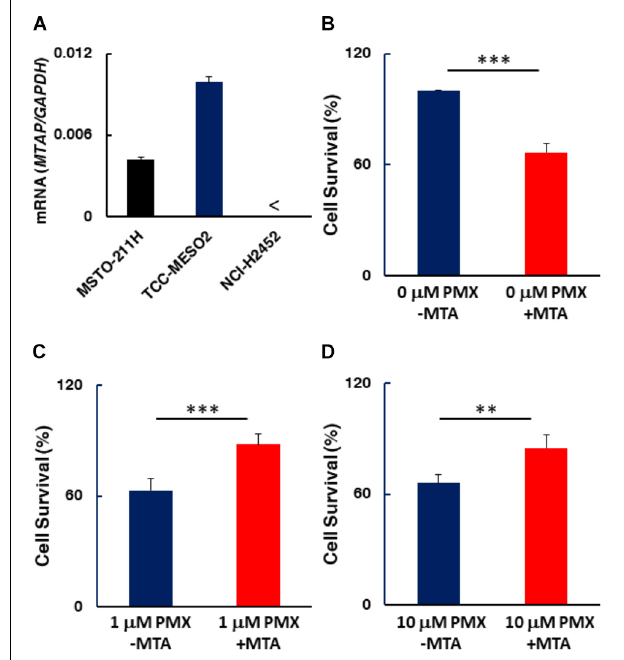
FIGURE 7 | MTAP expression in MPM cells and effect of MTA on MPM cell survival. (A) MTAP mRNA expression was evaluated by real-time RT-PCR using the (cid:49)(cid:49) CT method normalized to the housekeeping gene GAPDH. < indicates not detected (N.D.). Error bars indicate s.d. (n = 6). (B–D) Addition of 5 (cid:48) -deoxy-5 (cid:48) -(methylthio)-adenosine (MTA) represses drug-resistant cells. NCI-H2452 cell survival (%) was measured in the presence of 0.1 mM MTA co-treated without (B) or with either 1 µ M (C) or 10 µ M pemetrexed (D) . The data are shown as the mean ± s.d. ( n = 6). Error bars represent one s.d. ∗ P < 0.05, ∗∗ P < 0.01, ∗∗∗ P < 0.005 vs. control by two-tailed Student’s t